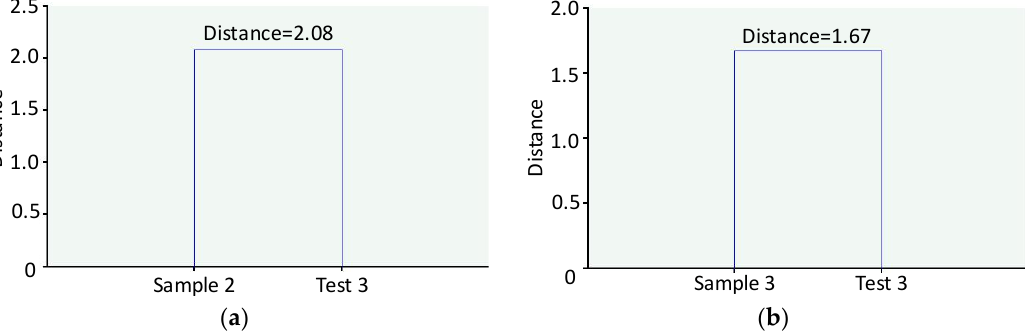
Figure 9. Results of the second clustering analysis carried out for Test 3 showing the distances between: ( a ) Test 3 and Sample 2; ( b ) Test 3 and Sample 3.